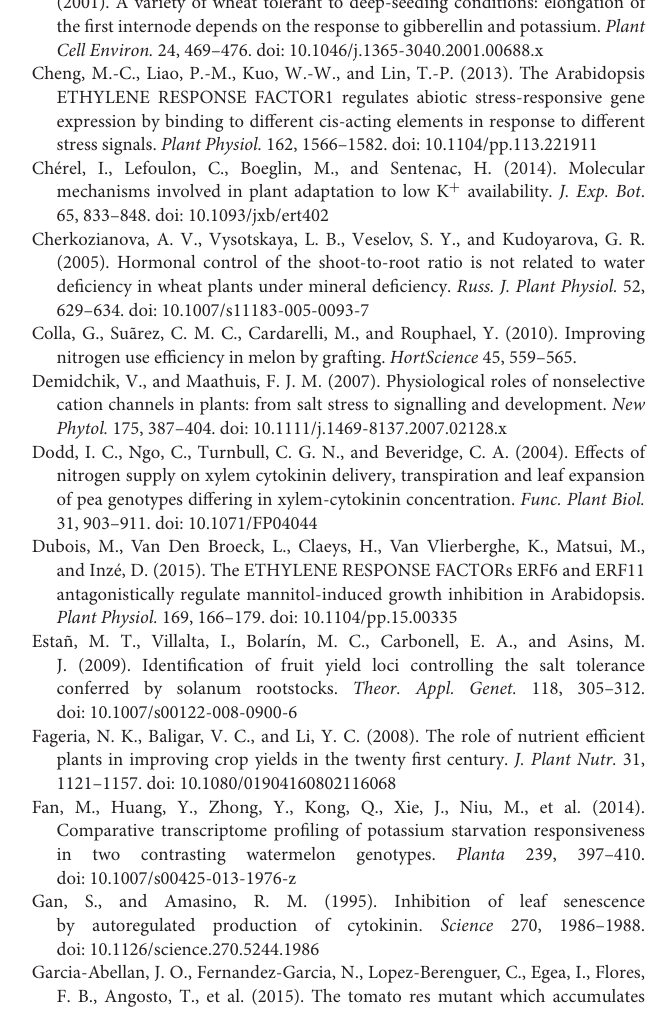
Table S1 | Two way ANOVA for the effects of the genotype and treatment on shoot fresh weight (SFW), K use efficiency (KUE) and K concentration in leaf (K leaf). The numbers in the table are F- and P-values. Figure S1 | Shoot fresh weight (SFW) correlation between control (C) and low K condition (K) of tomato plants ( Solanum lycopersicum cv. Boludo F1) grafted onto a population of recombinant inbred lines (RILs) from